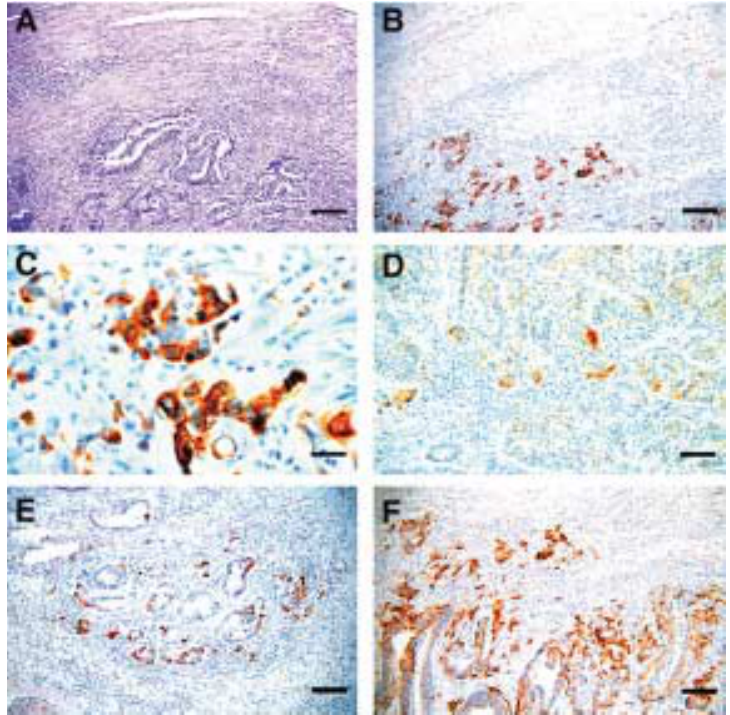
Fig. 1. Human colon adenocarcinoma stained by hematoxylin/eosin (H/E) (A) and immunohistochemistry for the γ 2 chain of laminin-5 (B–F). (A) Marked tumor budding. (B) Performed on an adjacent section to A, showing strong staining for the γ 2 chain in clearly budding cancer cells at the invasive front of the cancer. Note how clear the budding cells are visualized compared to H/E staining. (C) High magnification, demonstrating the strong cytoplasmic staining with the laminin-5 γ 2 chain antibody in budding cancer cells. (D–F) Showing a colon tumor representing a sparse (D), moderate (E) and frequent (F) γ 2 chain staining. Bars, 140 µ m (A, B, E and F), 24 µ m (C) and 36 µ m (D). This figure can be viewed on